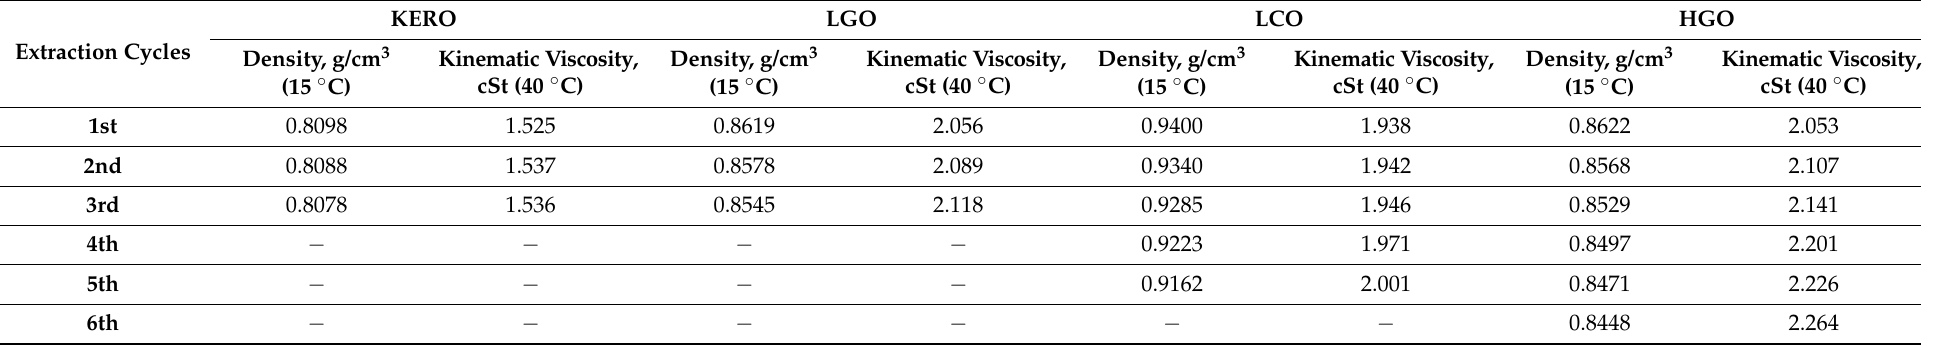
Table 9. Density and kinematic viscosity of the surrogate raffinates during the multiple-stage extractions with fresh [BMIM][HSO 4 ].